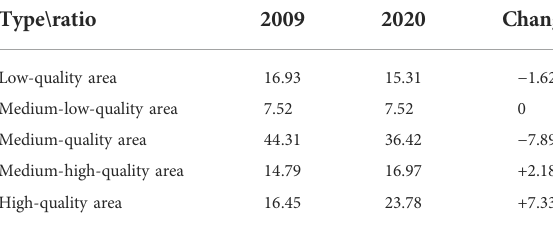
TABLE 5 Eco-environment quality grades